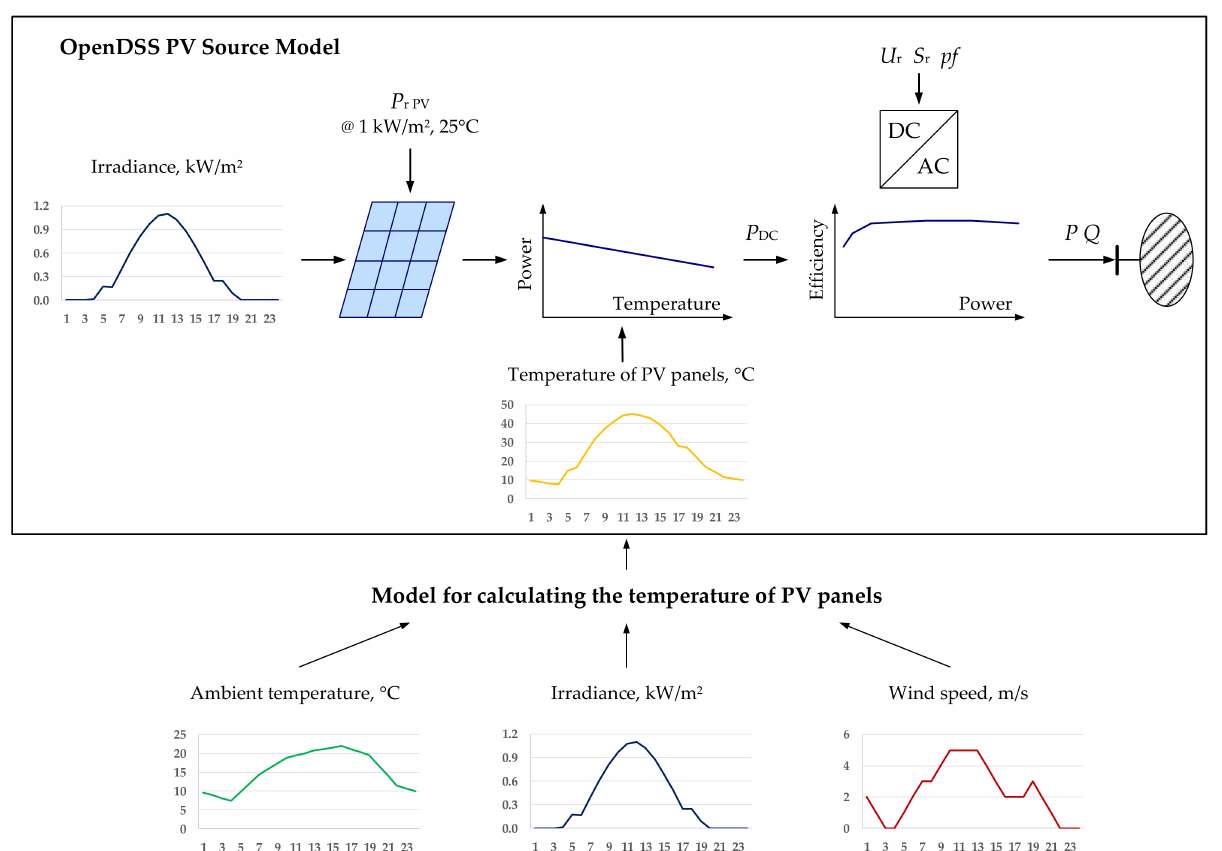
Figure 6. The PV source model used by OpenDSS, with the daily profiles of ambient temperature, solar irradiance, and wind speed based on the weather conditions on 17